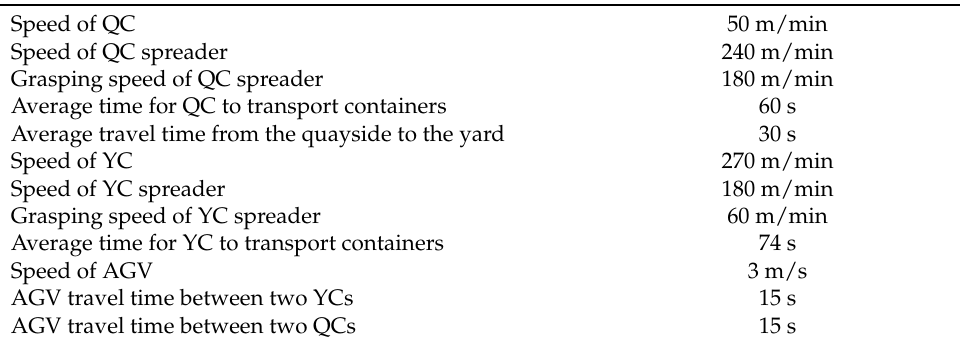
Table 5. The data obtained in Qingdao Port.